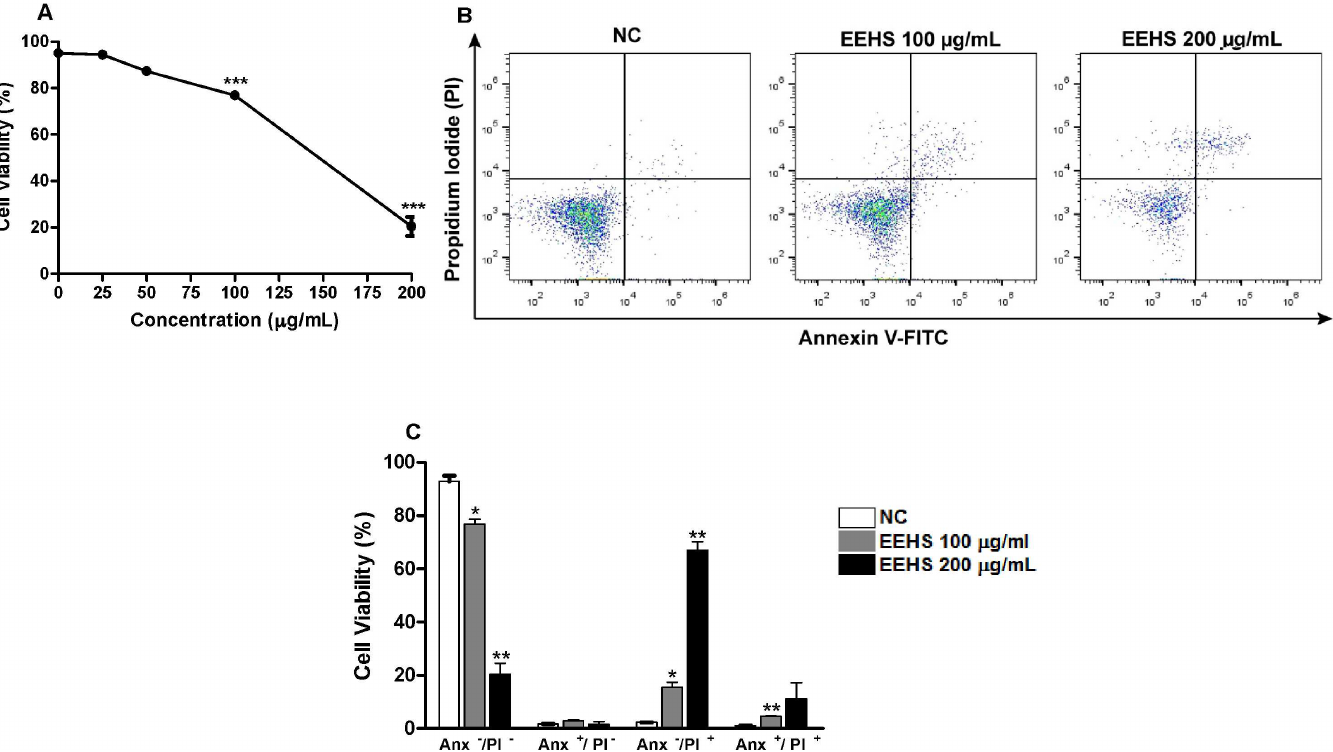
Fig 5. Cytotoxic activity of the EEHS in the acute myeloid leukemia cell line Kasumi-1. (A) Concentration-response curve (25–200 μ g/mL). (B) Dot plots indicating the flow cytometry data of cells stainedwith propidiumiodide(PI) and annexin-V-FITC (An) treated with a negativecontrol (NC), 100 μ g/mL of the EEHS or 200 μ g/mL of the EEHS. The lower left quadrantshows viablecells (An – /PI – ); the lower right quadrant shows apoptotic cells (An + /PI – ); the upper left quadrantshows cells undergoingnecrosis (An – /PI + ); and the upper right quadrantshows cells in late apoptosis(An + /PI + ). (C) Percentage of cell death obtainedfrom dot plots of cells treated with NC, 100 μ g/mL of the EEHS, or 200 μ g/mL of the EEHS. * P < 0.05, ** P < 0.01 and *** P < 0.001 when the treated groupswere comparedwith the control group.